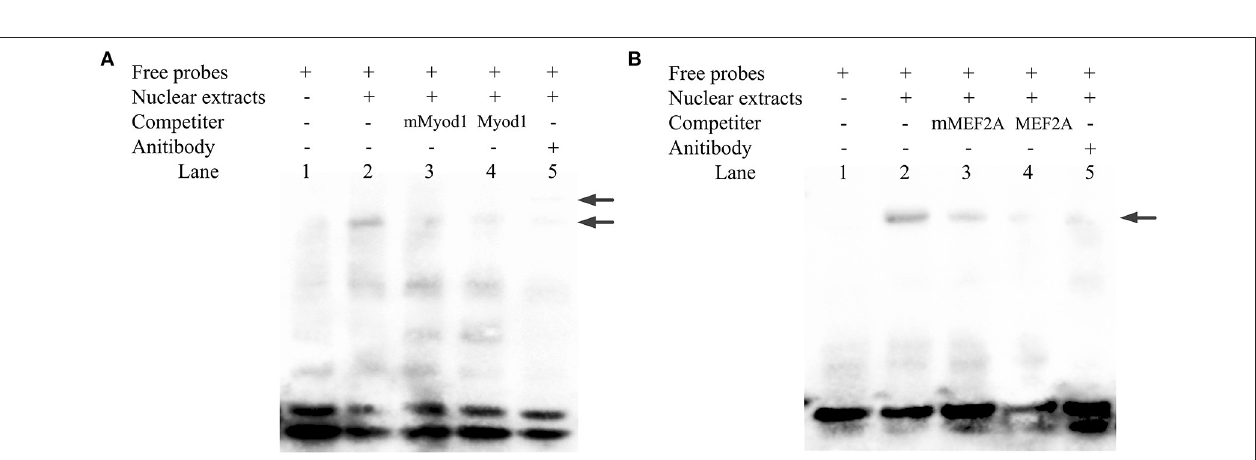
FIGURE 6 | Identification of Myod1 and MEF2A bind to the proximal minimal promoter of LATS 1 by electrophoretic mobility shift assay (EMSA) in vitro . (A,B) Nuclear protein extracts were incubated with 5 ′ -biotin-labeled probe containing the Myod1- and MEF2A-binding site in the presence or absence of competitor (lane 2), 50X mutation probe (lane 3), and 50X unlabeled probes (lane 4). The supershift assay was conducted using 10 µ g of anti-Myod1 and anti-MEF2A antibodies (lane 5). The arrows mark the main complexes and supershifted,